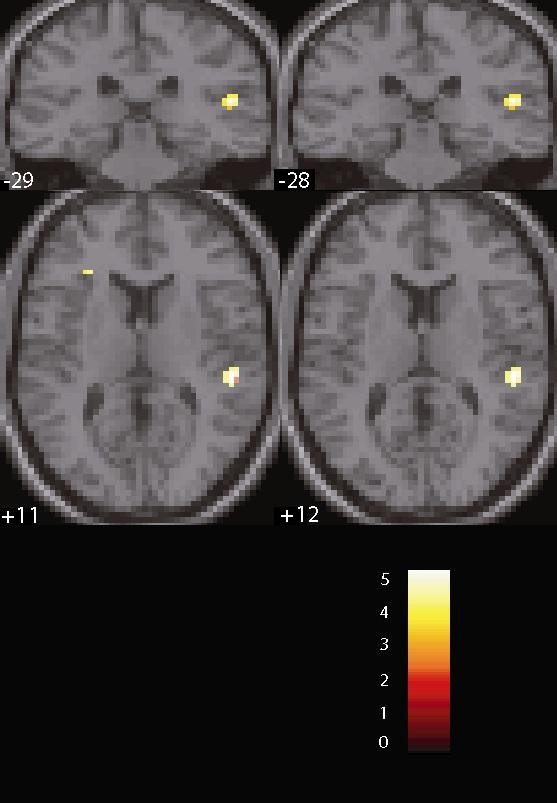
Coronal and axial sections displaying activation differences between family history positive (FHP) and family history negative (FHN) participants in the right Heschl's gyrus (T = 4.60, PFWE = 0.01). FWE: whole brain family-wise error correction.